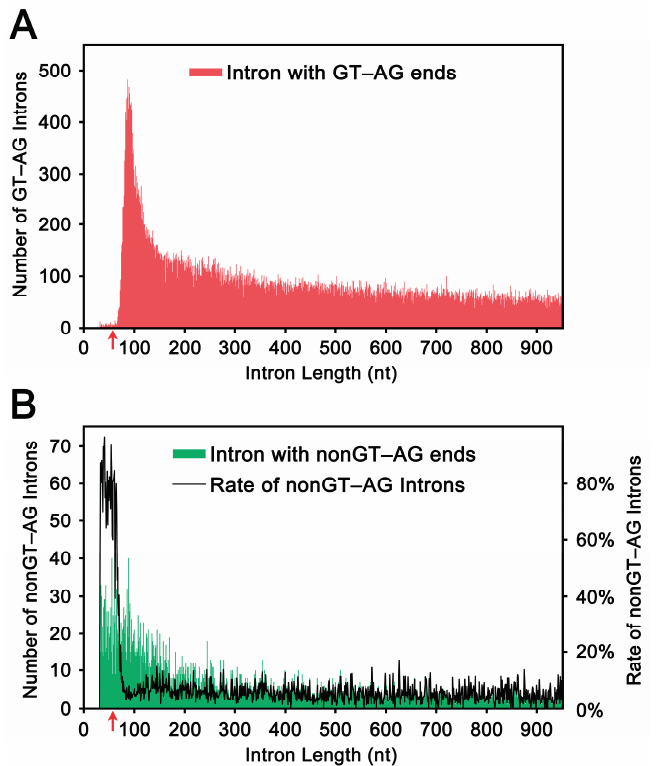
Figure 1. The length distribution of human introns ( ≤ 949 nt). ( A ) The lengths of introns with terminal GT and AG bases were plotted (red shading) based on the calculated lengths using H-InvDB annotation. The red arrow indicates the threshold (65 nt) from which the number of introns with GT–AG increases drastically toward the first peak at 83 nt; and ( B ) The lengths of introns with terminal non-GT and non-AG bases were plotted (green shading) in the same way. The rate of the number of non-GT–AG introns to the number of GT–AG introns was plotted with black line. The red arrow indicates the threshold (65 nt) from which the ratios of non-GT–AG introns to GT–AG introns decreased